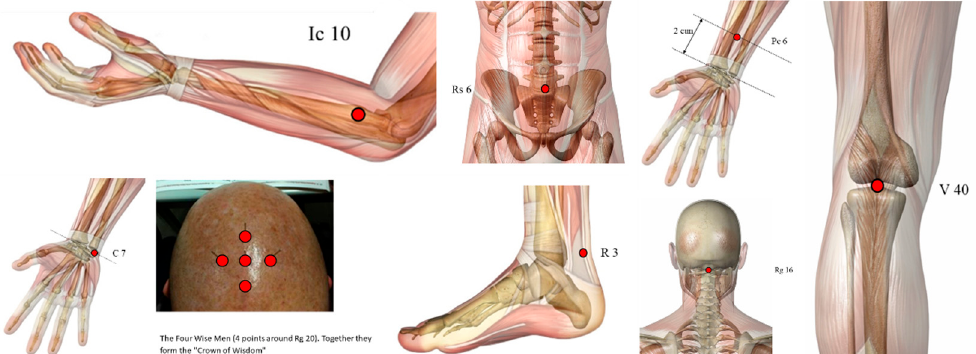
Figure 2. Ilustration of the most used points (highlighted in red dots): GB20 ( Fengchi ), LI4 ( Hegu ), GB34 ( Yanglingquan ), GV20 ( Baihui ), ST36 ( Zusanli ), LR3 ( Taichong ), SP6 ( Sanyinjiao ), GV14 ( Dazhui ), and LI11 ( Quchi ).